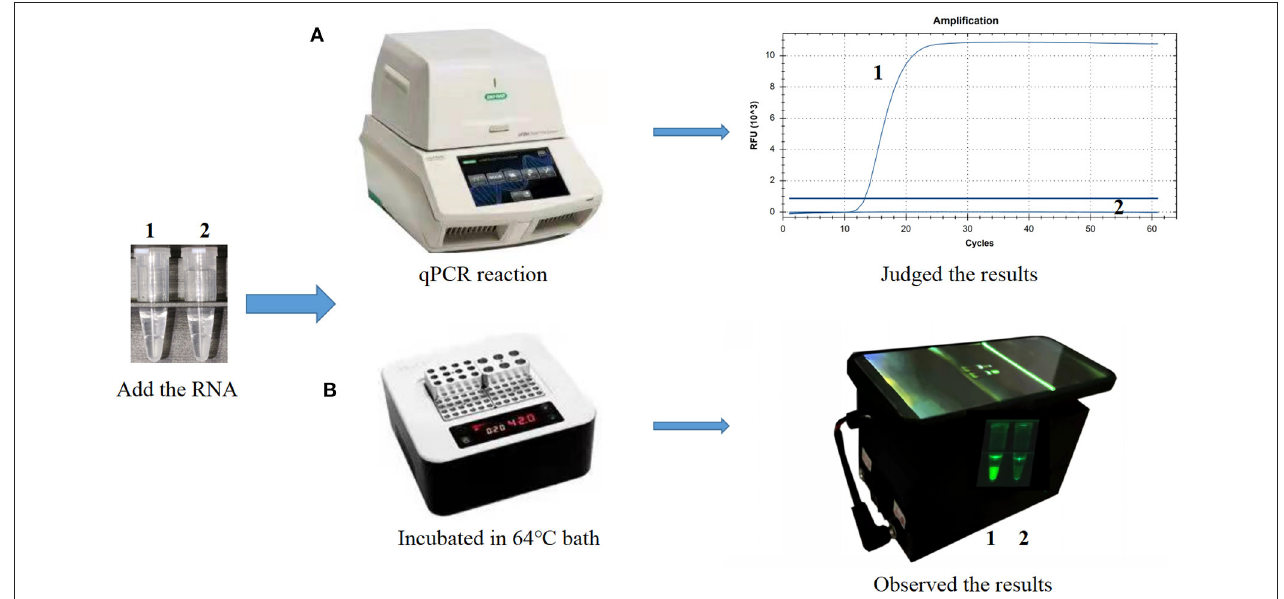
FIGURE 1 | Establishment of the cleaved probe-based reverse transcription loop-mediated isothermal amplification (CP-RT-LAMP) assay for porcine deltacoronavirus. (A) CP-RT-LAMP assay using the CFX96 Touch real-time PCR detection system. (B) Flowchart of the CP-RT-LAMP method combined with a